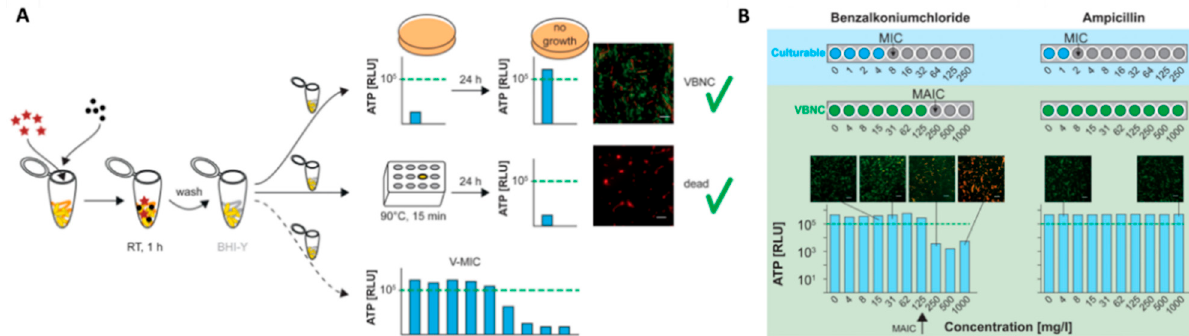
Figure 6. Workflow of the VBNC-minimum inhibitory concentration (MIC) assay, adapted from [170]. ( A ) The VBNC state is induced by a specific combination of detergent (stars) and salt (dots); after induction, cells are washed and resuspended in a fresh Brain Heart Infusion (BHI) medium; positive control: Untreated VBNC cells confirmed by ATP measurements and BacLight ™ viability assay; negative control: VBNC cells killed at 90 °C for 15 min; minimum ATP inhibitory concentration (MAIC) of antimicrobials is determined by measuring the de novo ATP production of VBNC cells exposed to the respective antimicrobial, viability marker: 10 5 relative light units (RLU) threshold. ( B ) VBNC-MIC assay MIC determination for culturable and MAIC determination for VBNC L. monocytogenes against benzalkonium chloride and ampicillin.